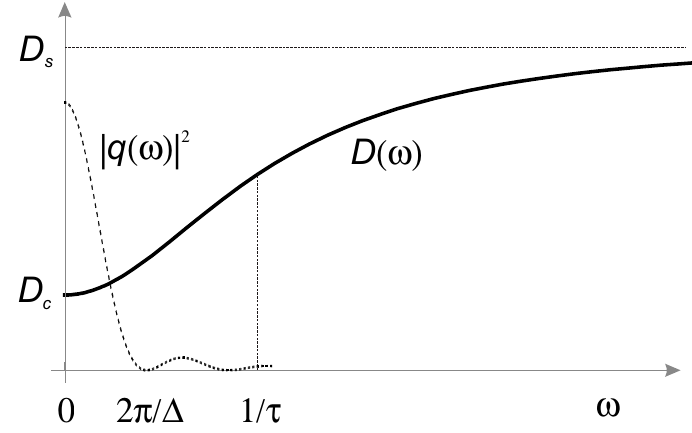
Figure 1. The diffusion spectrum (cid:1830)((cid:2033)) of a polymer melt and the sampling function |(cid:1869)((cid:2033))| (cid:2870) of the Figure 1. The di ff usion spectrum D ( ω ) of a polymer melt and the sampling function | q ( ω ) | 2 of the pulsed gradient spin-echo (PGSE) pulsed gradient spin-echo (PGSE) sequence.